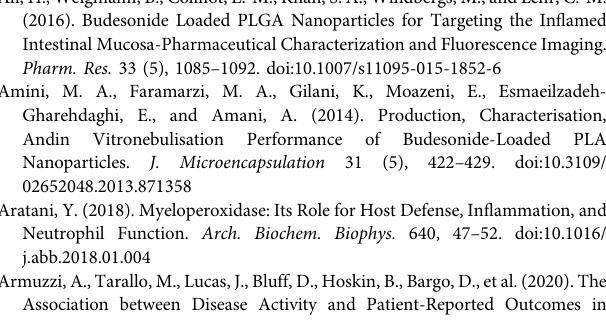
Frontiers in Bioengineering and Biotechnology |